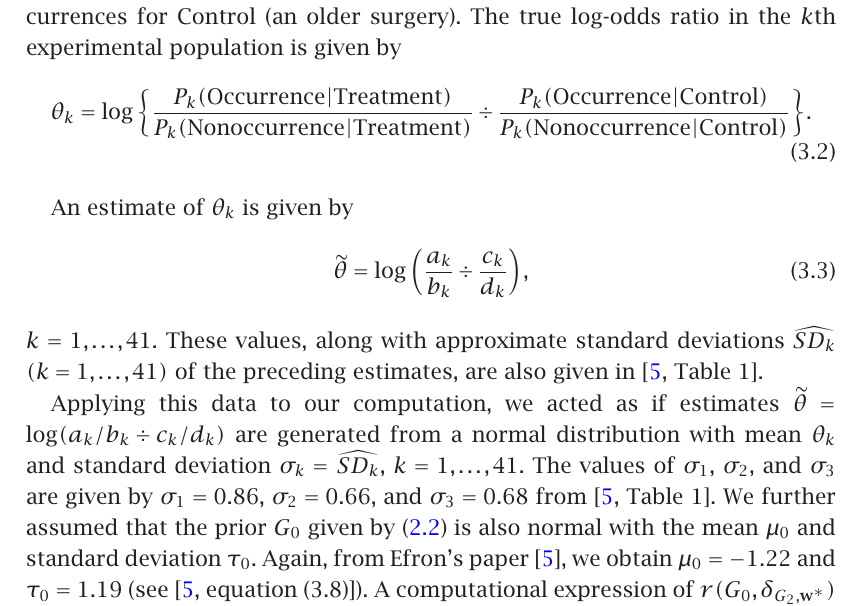
Table 3.1 . Efficiency of δ G